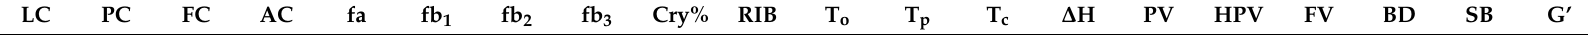
Table 5. Pearson correlation coefficients among physicochemical and structural properties of wheat starch and grain hardness